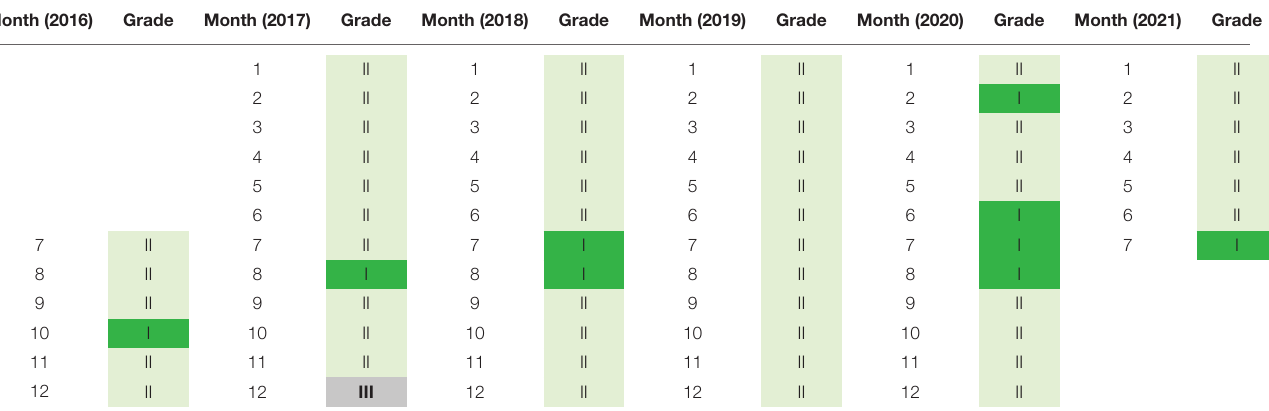
TABLE 7 | Monthly grade results based on ID-FCE (July 2016–July